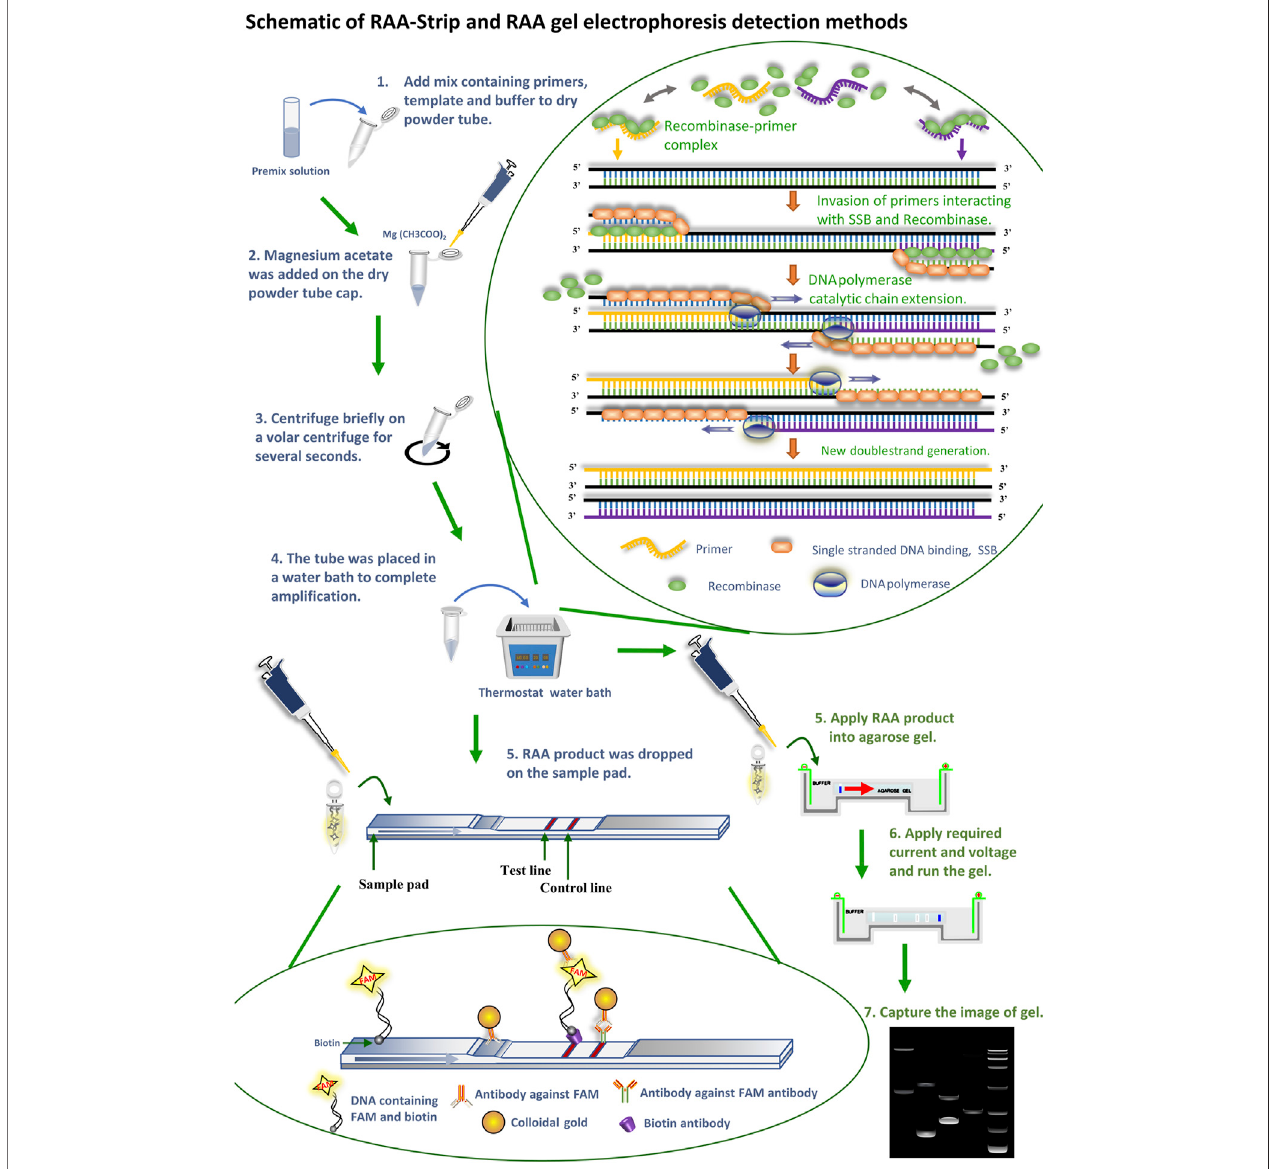
FIGURE 1 | Schematic of RAA-Strip and RAA gel electrophoresis detection methods. Flow of RAA-strip and RAA gel electrophoresis assays are illustrated in the fi gures in blue and green text, respectively. The reaction principle of the RAA technique is shown in the fi gure, the recombinase combines with a primer to form a binary complex when the primer corresponds one-to-one to the template DNA at 37 – 42 ° C, With the help of single-stranded DNA-binding protein (SSB), the template DNA unwinding becomes two single strands after being separated, and the action of DNA polymerase makes it bind again, at which point a new reaction strand can be synthesized and fi nally achieving a large amplicons. The primers used above were added with probes to produce FAM and biotin labeled amplicons. Afterwards, DNA molecules containing FAM and biotin dual label were speci fi cally bound to an antibody against FAM labeled with gold particles to constitute a ternary complex, and